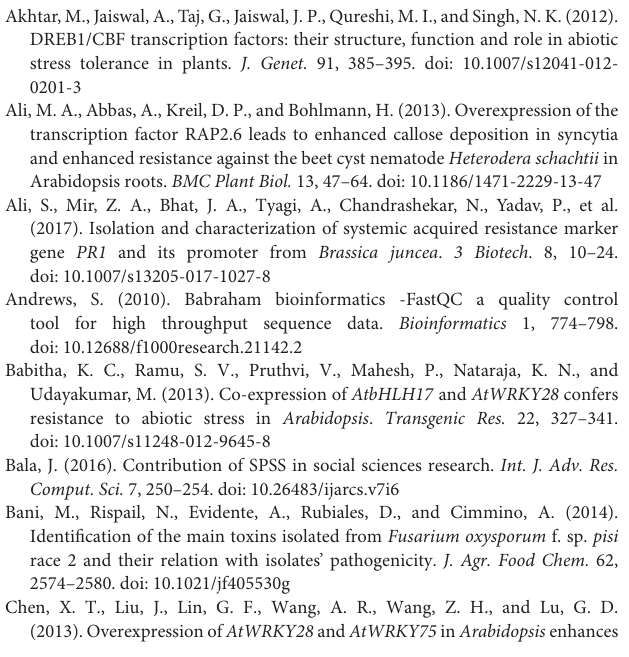
Supplementary Table 11 | Differential expressed genes with more than 3-fold